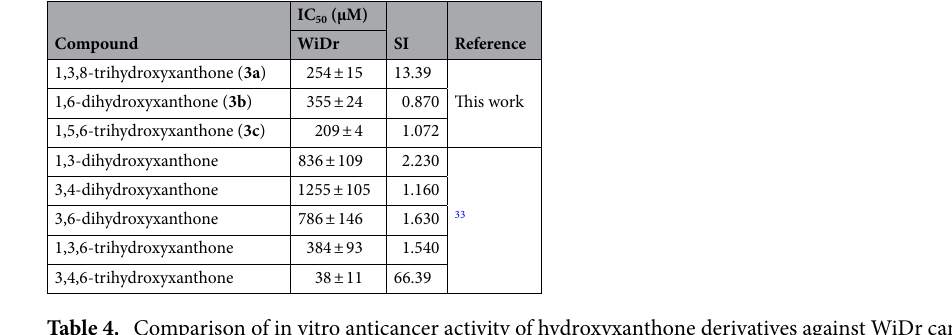
Table 4. Comparison of in vitro anticancer activity of hydroxyxanthone derivatives against WiDr cancer cell line.